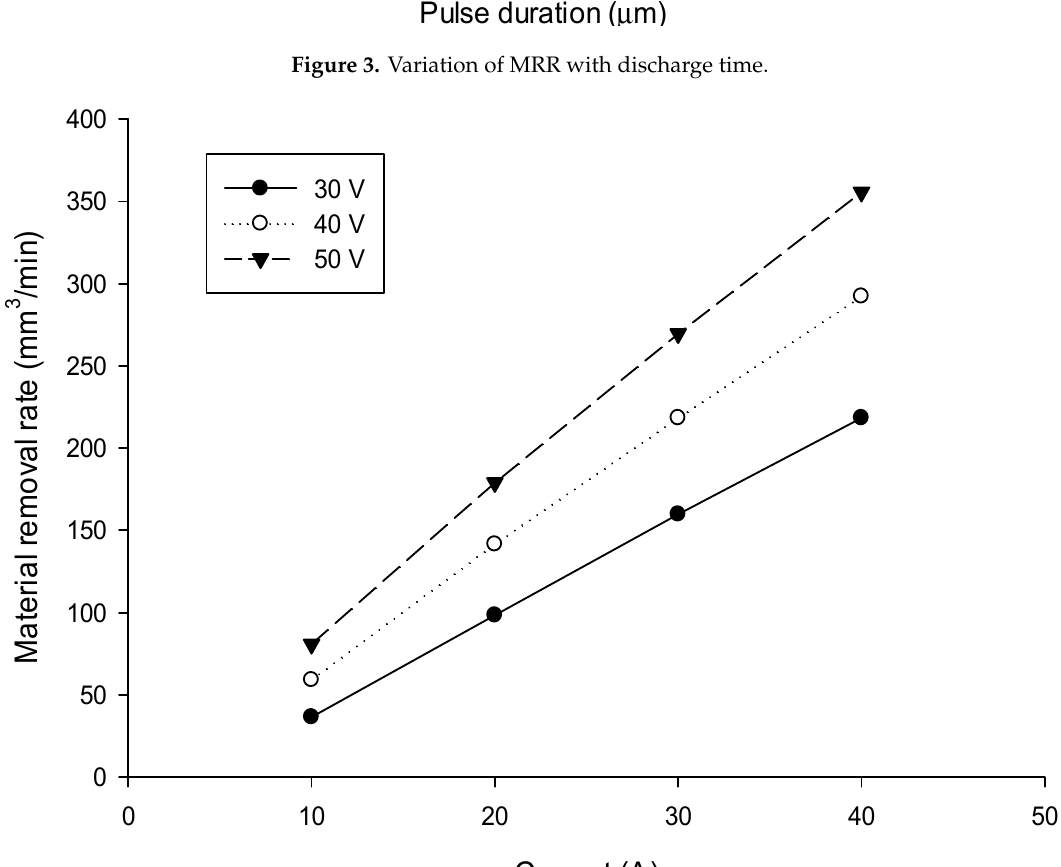
Figure 3. Variation of MRR with discharge time.